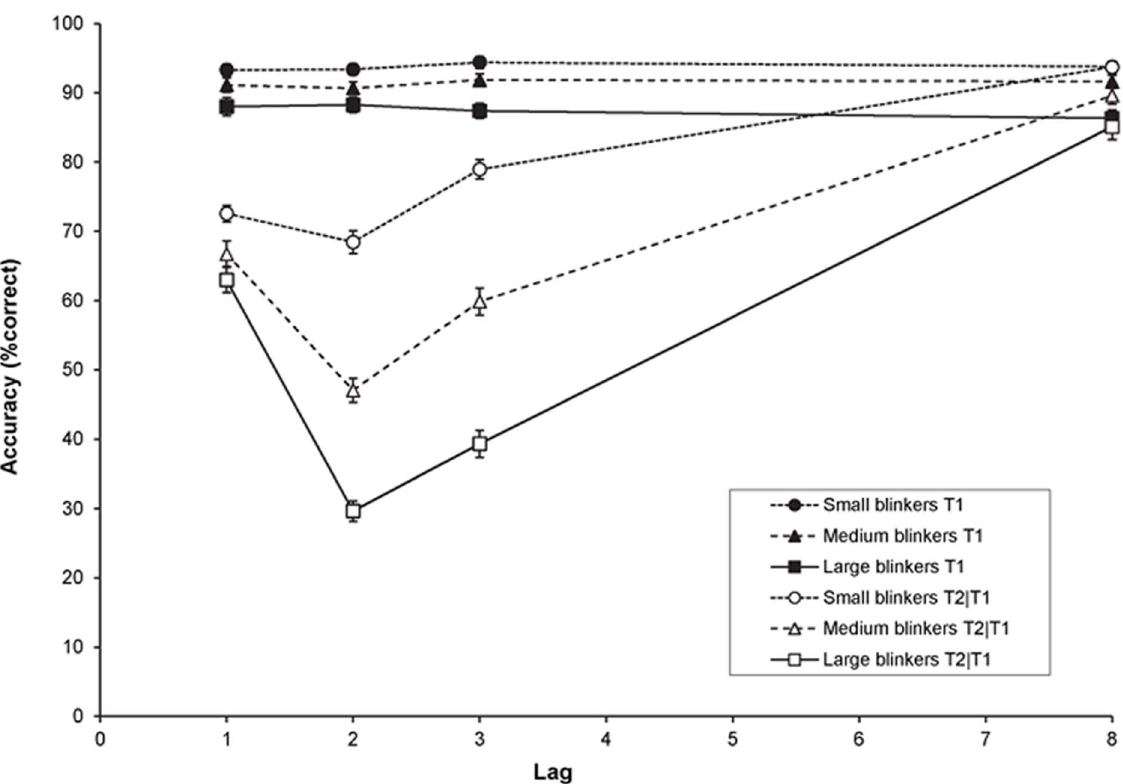
Figure 8. Target accuracy in Experiment 2. Mean percentage correct report of T1 (black symbols) and T2 given correct report of T1 (white symbols) as a function of lag, for small blinkers (circles), medium blinkers (triangles), and large blinkers (squares). Error bars reflect standard error of the mean.